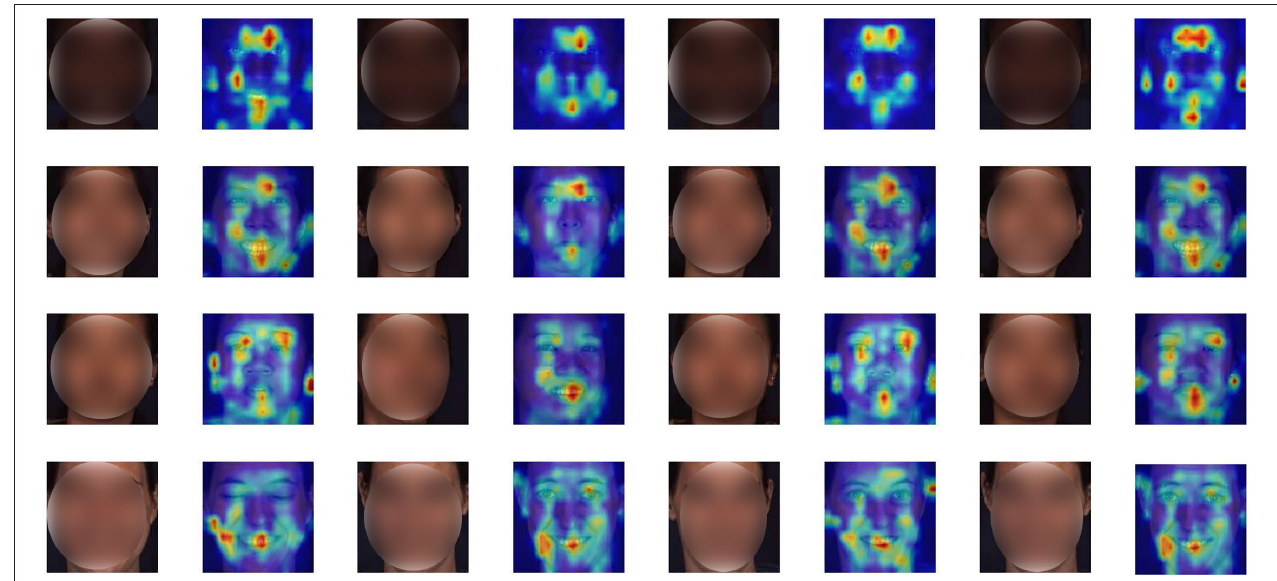
FIGURE 1 | Attention maps of some faces. Our proposed PMVT is capable of capturing the AU-specific facial regions for different identities with diverse facial expressions.